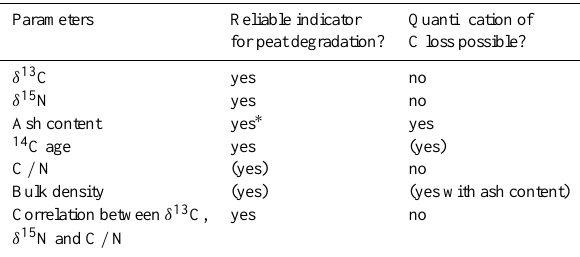
Table 3. Biogeochemical parameters from the Ahlen-Falkenberger peatland profiles as indicators of peatland degradation as well as peat and carbon